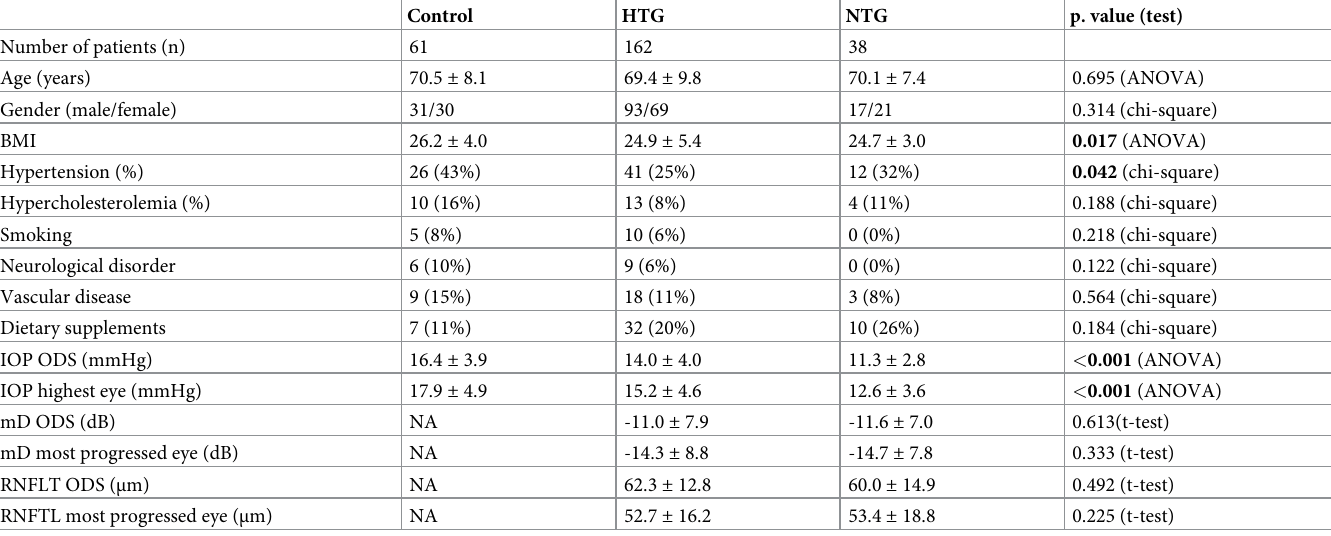
Table 2. Characteristics of the patient groups with OAG patients classified into HTG and NTG.